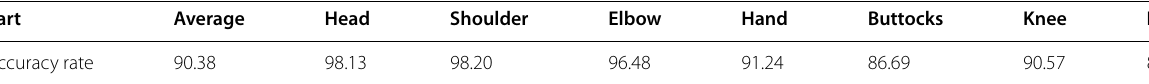
Table 2 The prediction results of different human key points (unit: %) Part